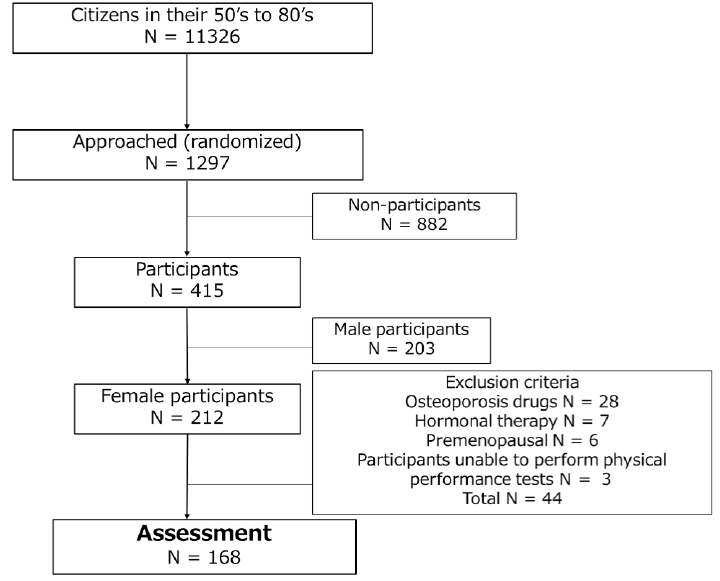
Figure 1. Participant selection flowchart.